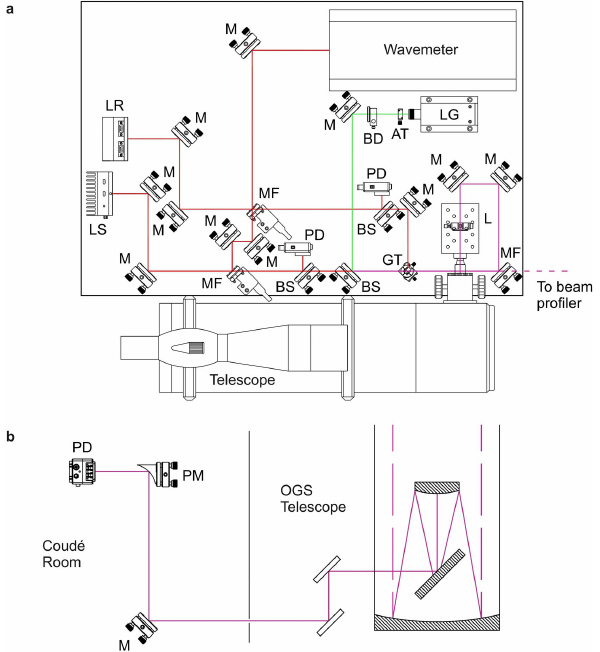
Fig. 2. Schematic diagram of the optical Tx and Rx breadboards. (a) Tx. (b) Rx. AT – neutral density filter to attenuate green laser (when necessary), BD – beam dump in motorized flipping mount, BS – dichroic beam splitter with transmission enhancing coating